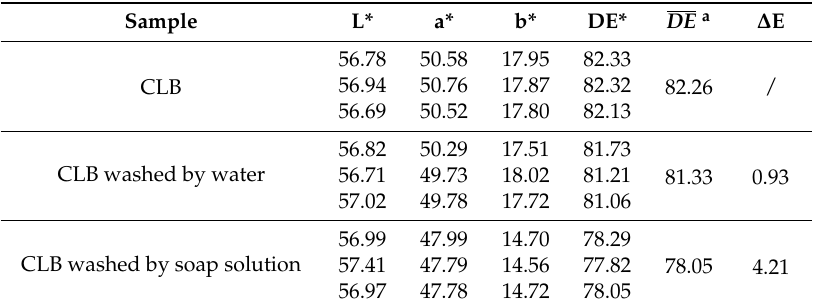
Table 2. The color coordinates of CLB before and after being